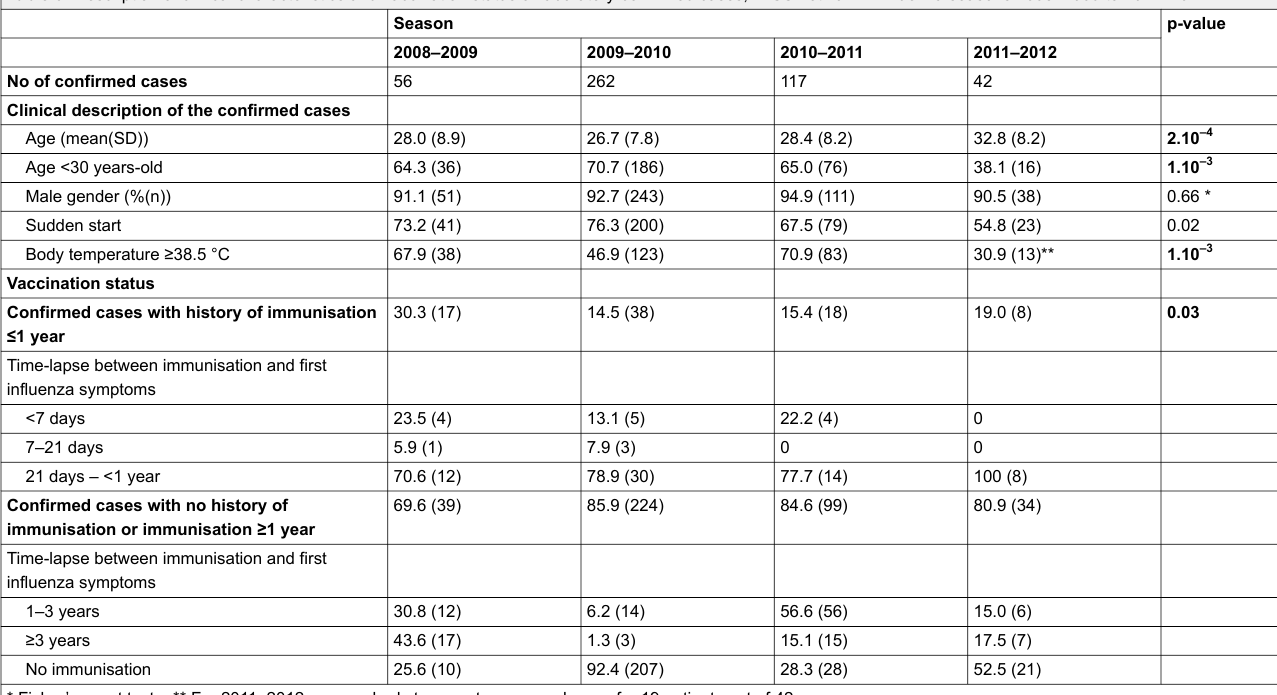
Table 3: Description of clinical characteristics and vaccination status of laboratory-confirmed cases, MISS network – influenza seasons 2008–2009 to